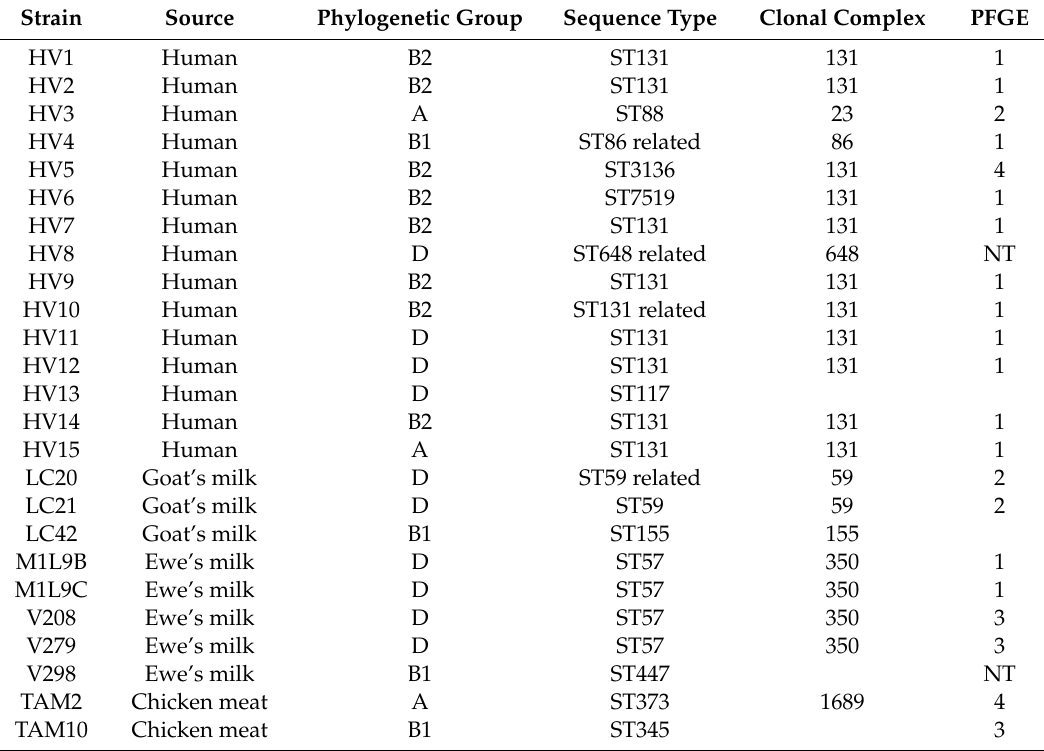
Table3. Geneticcharacterizationofhumanandfood E.coli isolates.